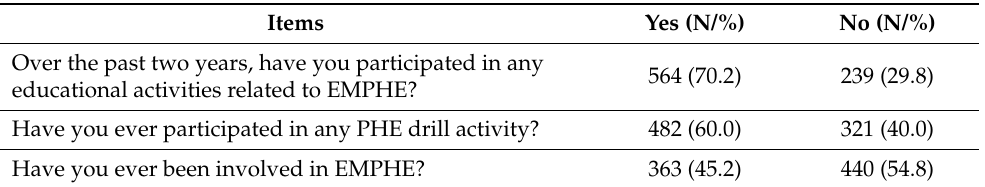
Table 3. Previous experience of the healthcare workers regarding training, drills, and participation in PHE management (N = 803).